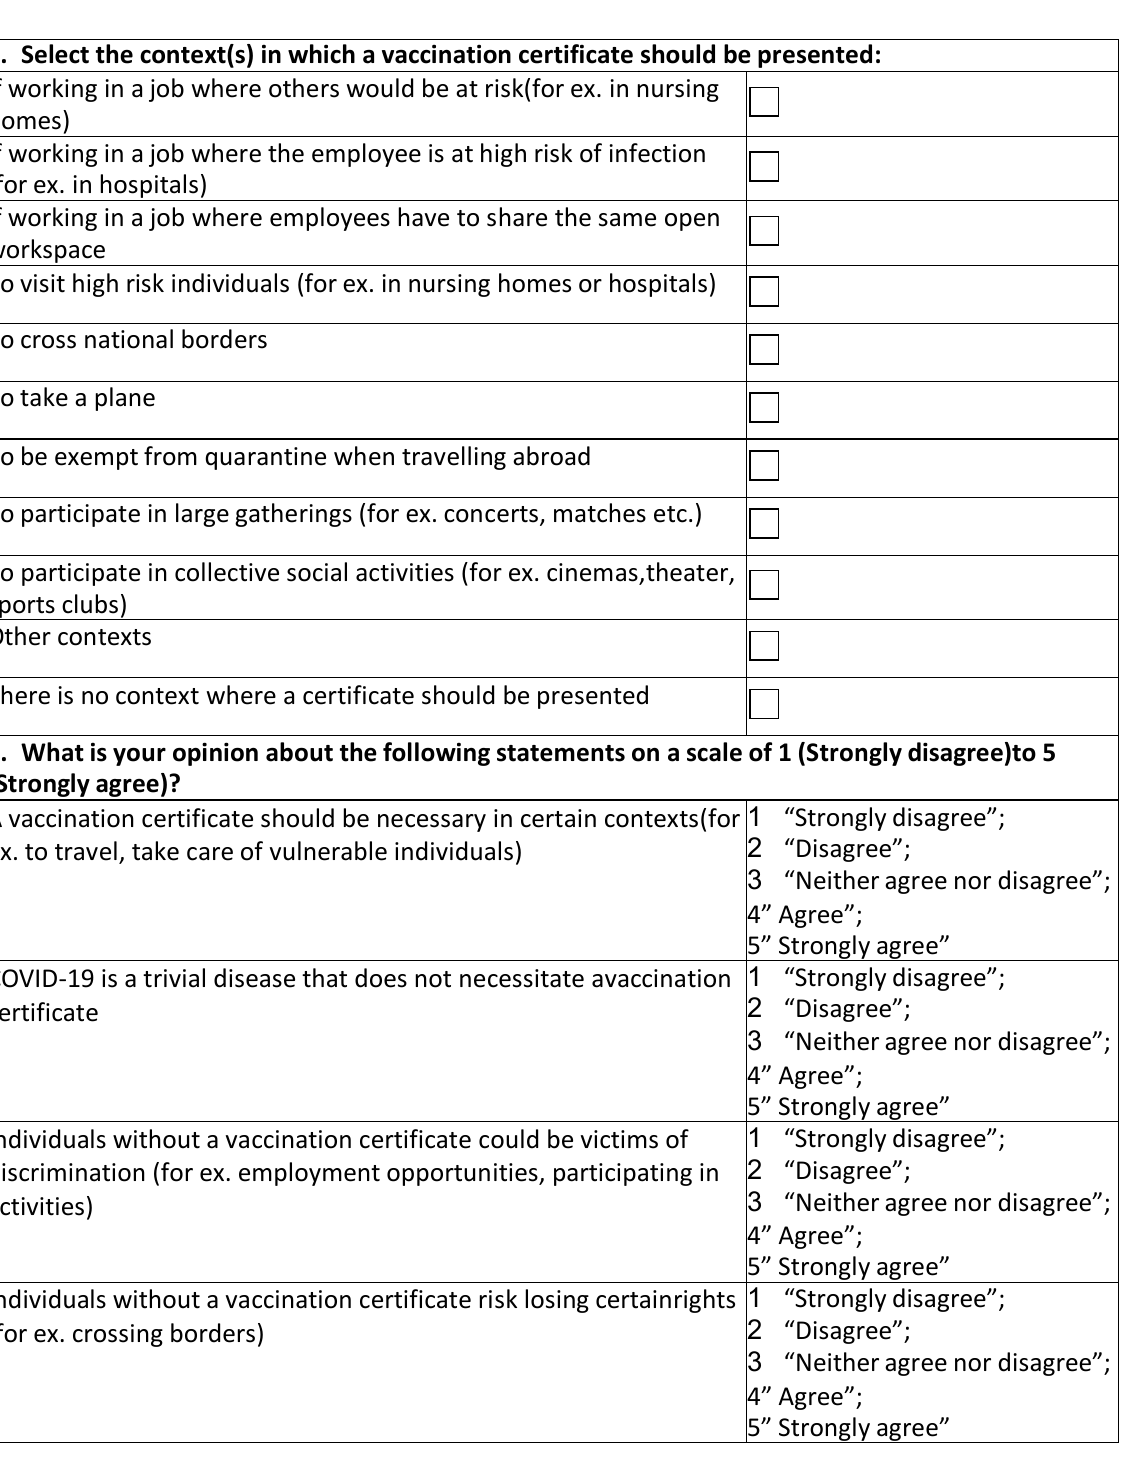
Table S1. Survey items on vaccination